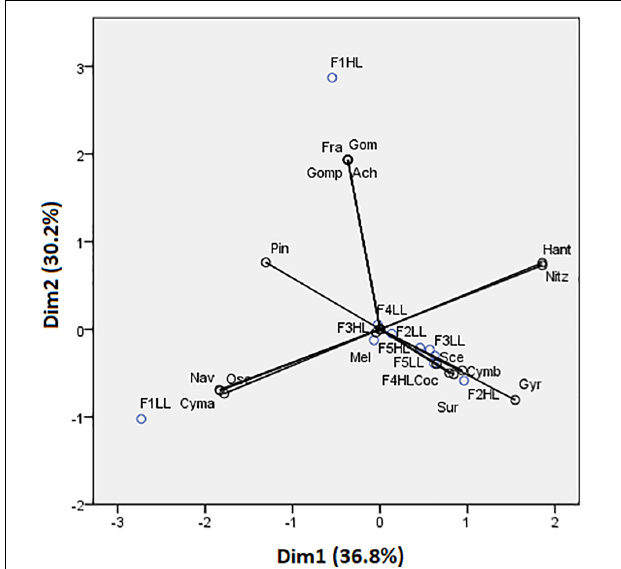
FIGURE 4 | Principal component analysis (PCA) showing flumes distribution based on biofilm species. Axes 1 and 2 combined explain 66.98% of the variance. Cyanobacteria: Osc = Oscillatoria sp. and Gom = Gomontiella sp.; diatoms: Mel = Melosira sp.; Cmb = Cymbella sp.; Nit = Nitzschia sp.; Gomp = Gomphonema sp.; Coc = Cocconeis sp.; Nav = Navicula sp.; Ach = Achnantes sp.; Gyr = Gyrosigma sp.; Sur = Surirella sp.; Pin = Pinnularia sp.; Han = Hantzschia sp.; Cym = Cymatopleura sp.; Fra = Fragilaria sp.; and green algae: Sce = Scenedesmus